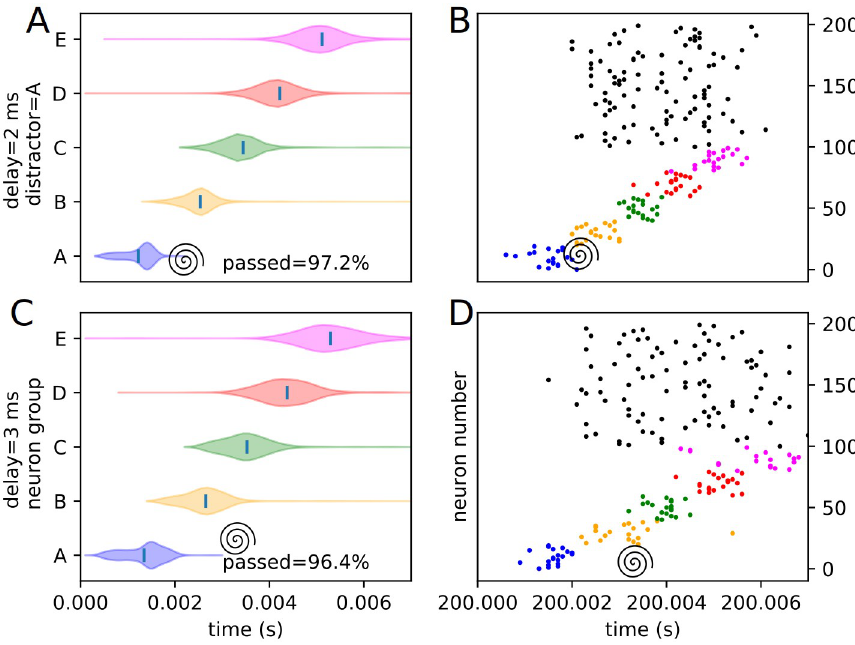
Fig 13. Experimental peak densities for late distractors at position A. Violin plots (densities estimated with a 50 point Gaussian kernel) of the peak times for the second two temporal variants of distraction at position A, with listed percentages of trials passing veto. A raster plot of an example distracted recall is also included. The spiral indicates the location of the distractor. (A) Violin plot for distractor A with 2 ms delay. (B) Example replay for distractor A with 2 ms delay. (C) Violin plot for distractor A with 3 ms delay. (D) Example replay for distractor A with 3 ms delay.